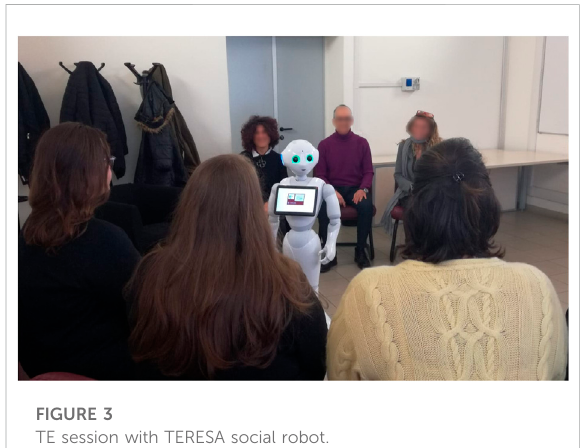
FIGURE 3 TE session with TERESA social